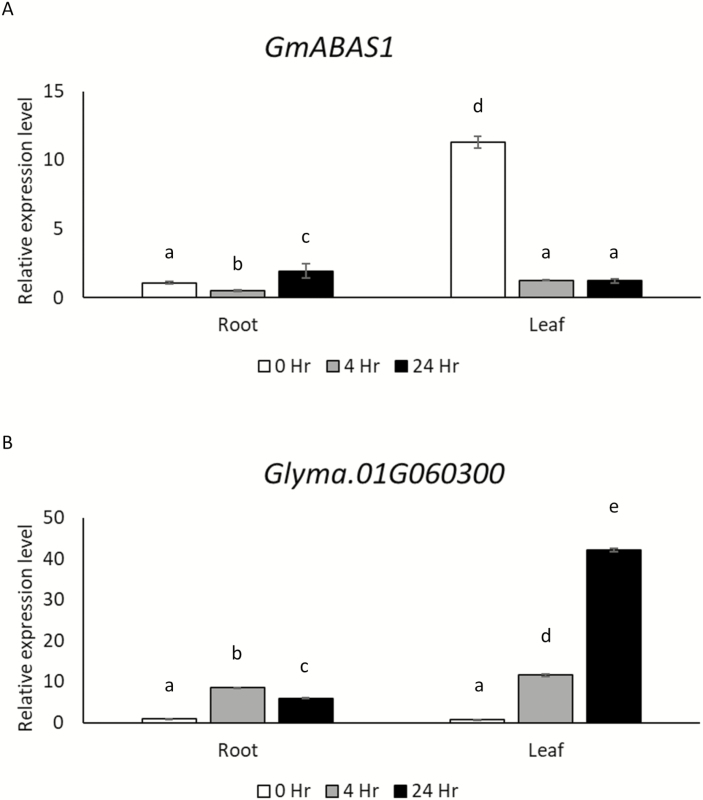
Osmotic stress-induced expression profiles of GmABAS1 and Glyma.01G060300. Soybean seedlings of W05 were treated with 300 mM mannitol in 1/2× Hoagland’s solution to induce osmotic stress for 0, 4, or 24 h respectively. Total cDNA was synthesized from total RNA for ddPCR. The copy numbers of mRNA of (A) GmABAS1 and (B) Glyma.01G060300 were normalized to that of ELF-1b (Yim et al., 2015). The error bar represents the SE of three technical repeats. Each lower caase letter above the bar indicates a statistically distinct group with P<0.05 based on one-way ANOVA followed by a least significant difference (LSD) test. The experiment was performed twice with similar results.